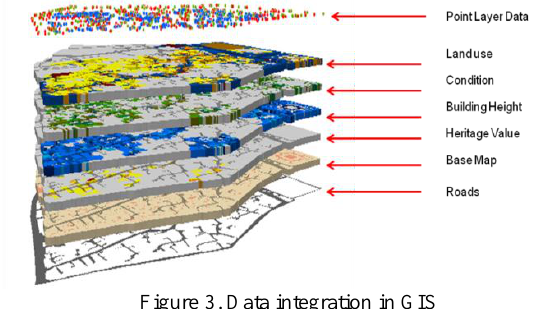
Figure 3. Data integration in GIS